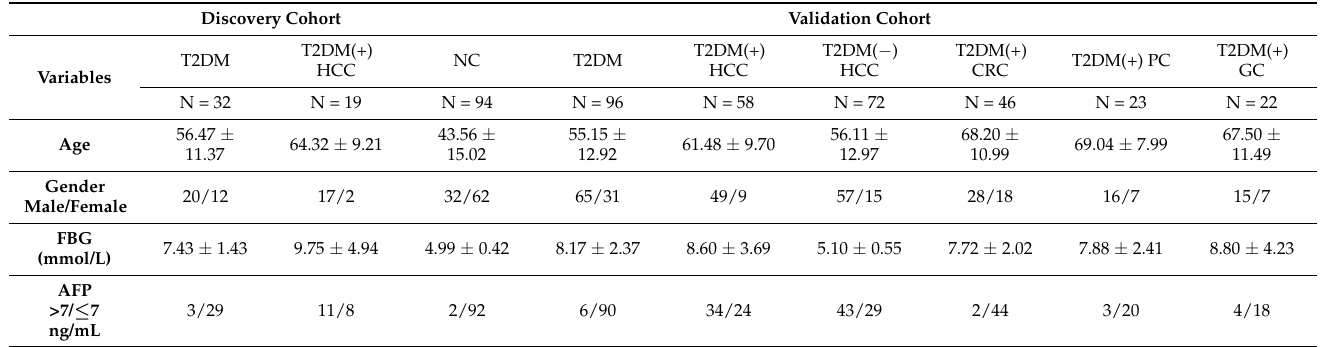
Figure 1. Design of the study. Table 1. The demographic and clinical variables of individuals included in this study.